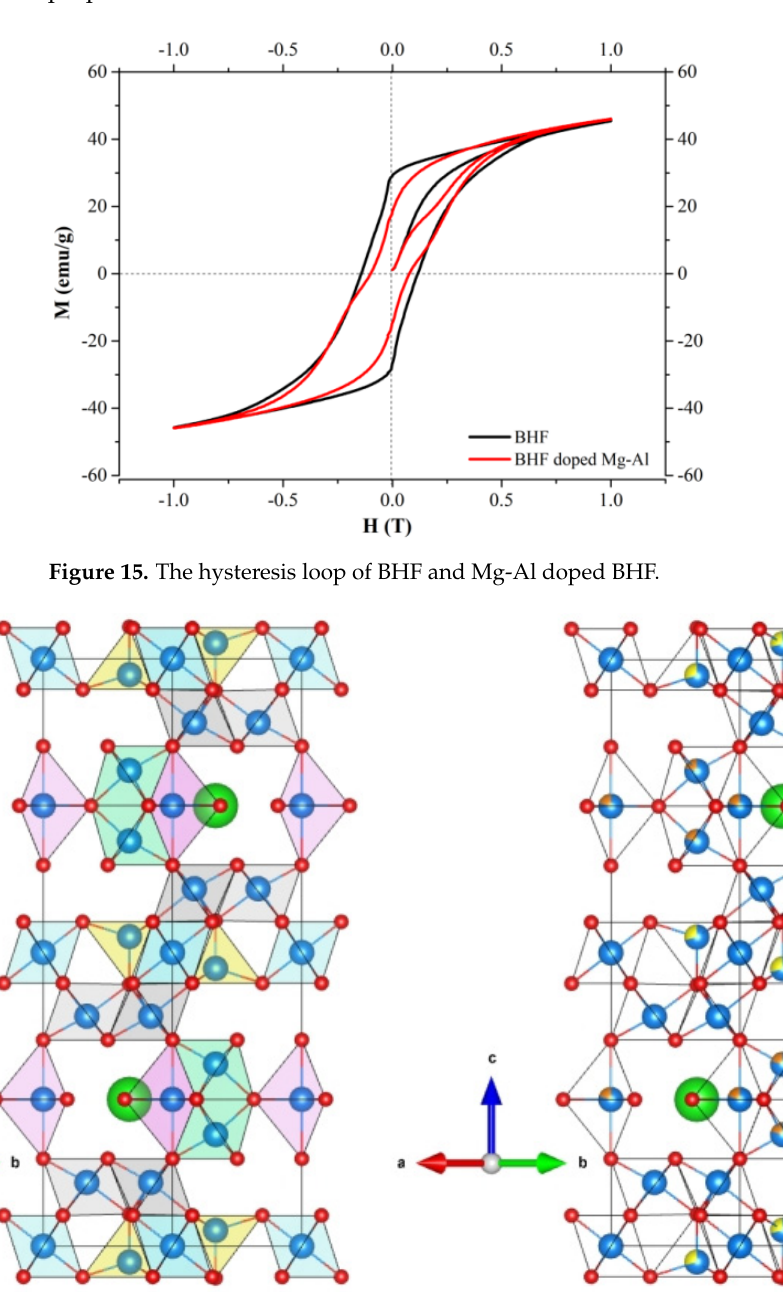
Figure 16. Crystal structure of ( a ) BaFe 12 O 19 with the five different Fe 3+ sites and ( b ) BaFe 11.2 Mg 0.4 Al 0.4 O 19 with most likely site occupancy. Polyhedral color code: grey, 12k; green, 4f2; blue, 2a; yellow, 4f1; pink, 2b; atomic color code: green, Ba; red, O; navy, Fe; orange, Mg; yellow, Al. It is well-known that there are five different sites in the unit cell of BaFe 12 O 19 in which Fe 3+ ions are distributed on five Wyckoff positions, namely 12k, 4f2, 4f1, 2b, and 2a, which are based on its coordination with O 2 − ions. These five Wyckoff positions are grouped as three octahedral sites (12k, 4f2, 2a), one tetrahedral site (4f1), and one bipyramidal site (2b) with the abundances of 6, 2, 1, 2, and 1, respectively [38]. Table 3 show the ionic radi for